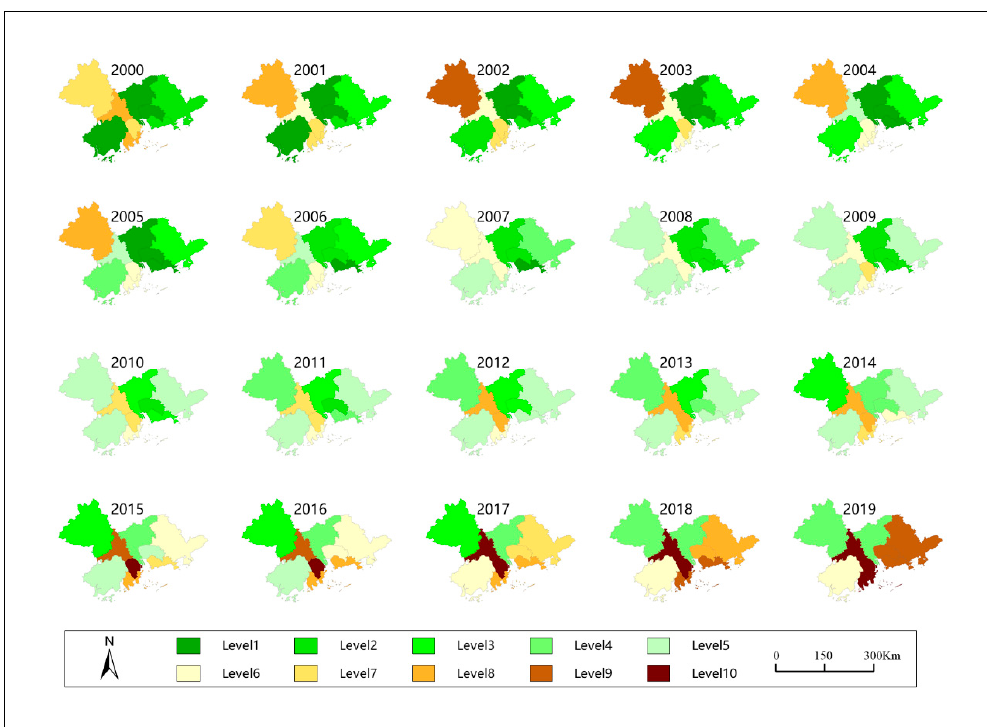
Figure 6. Level of the GTWR coefficient of foreign investment on the development of manufacturing in different years. in different